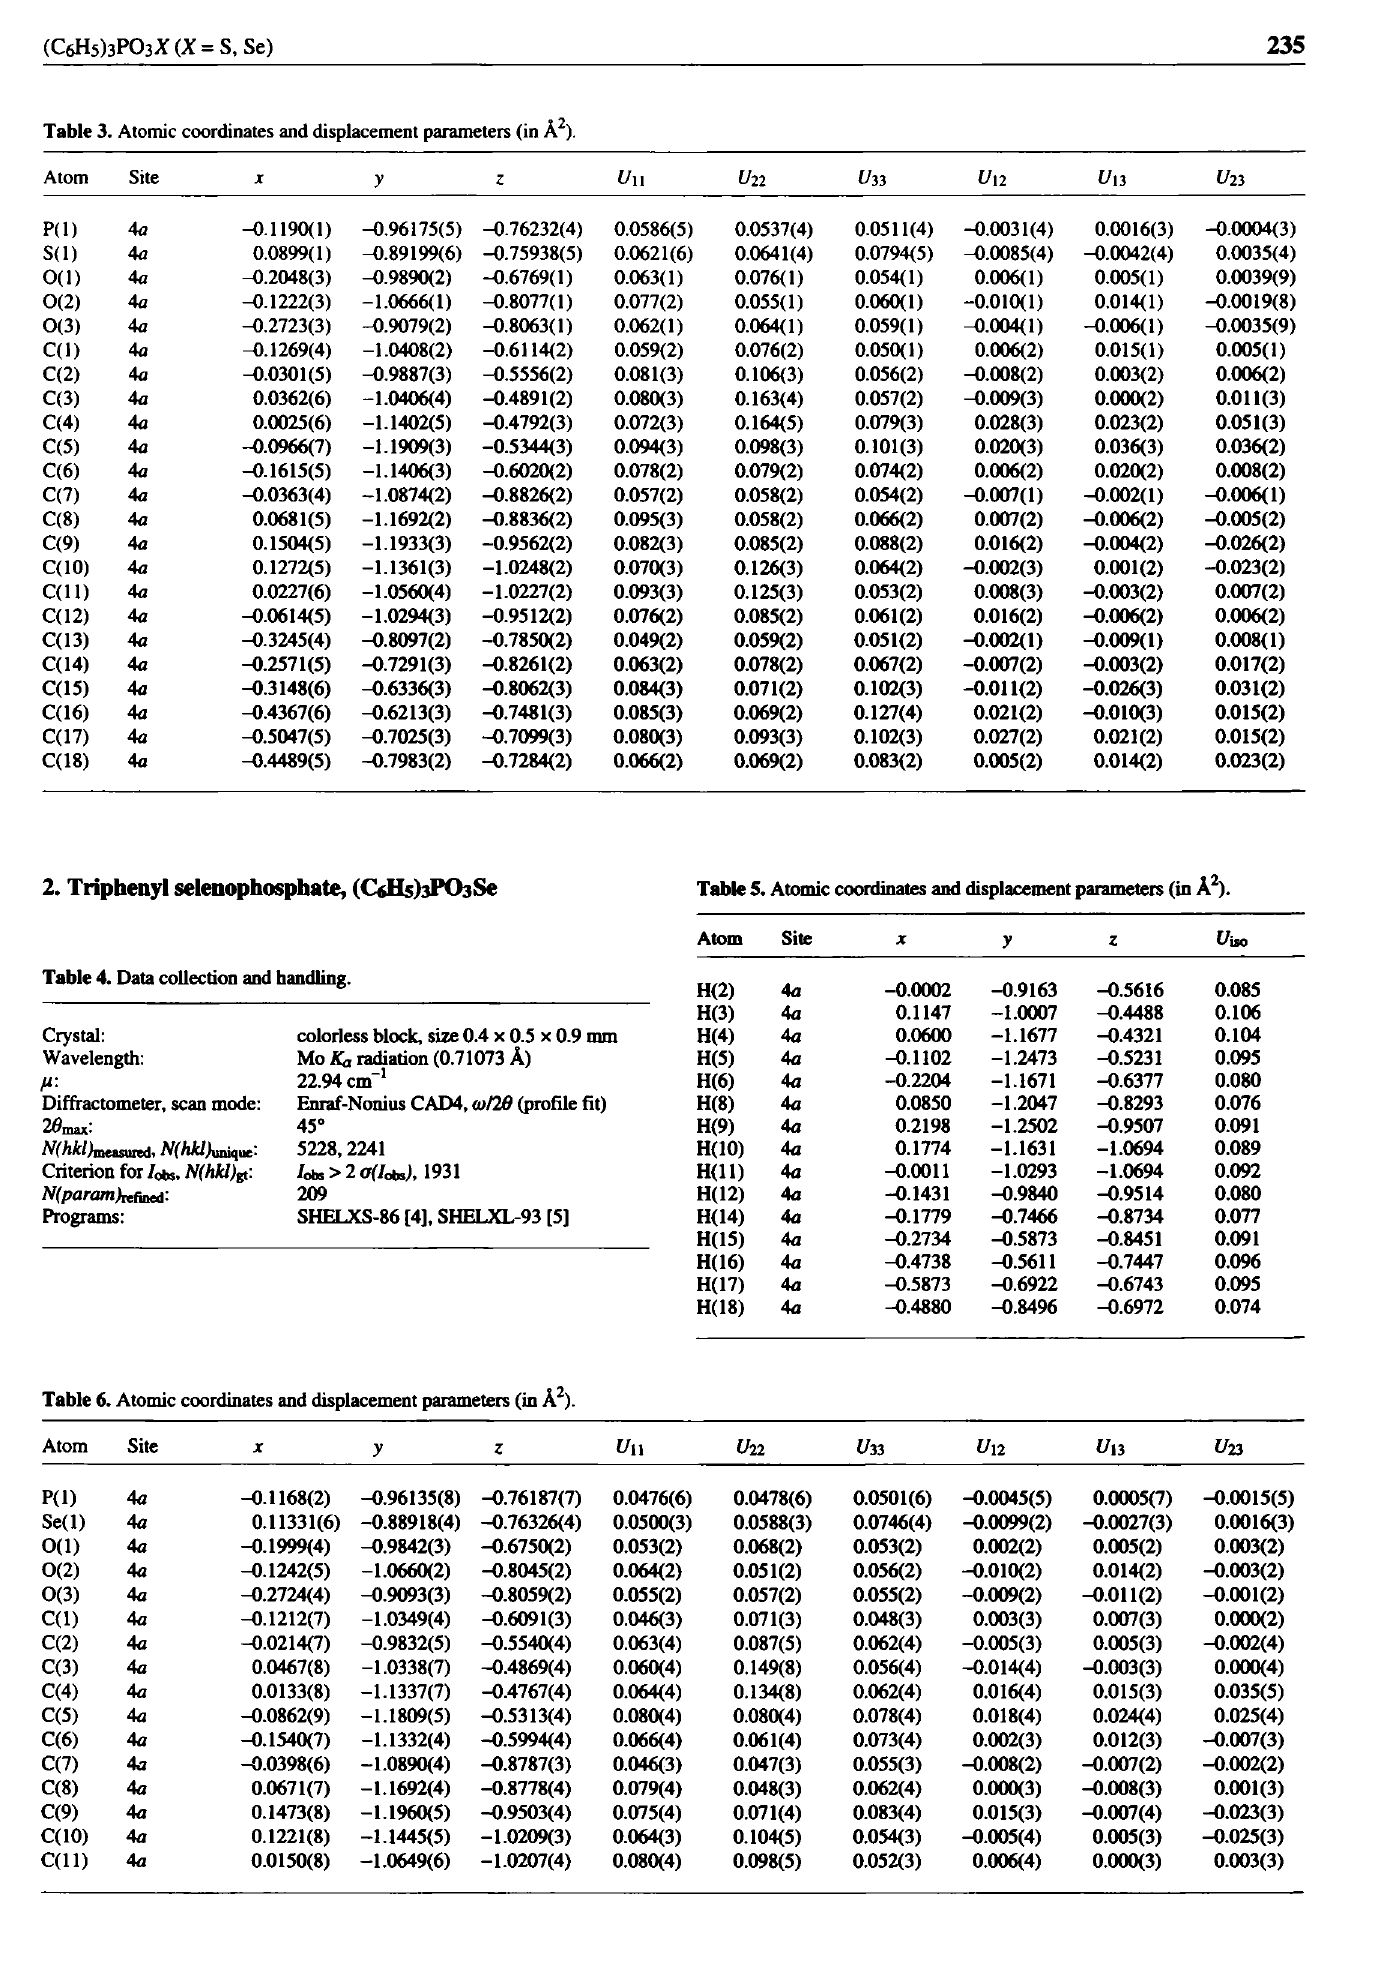
Table 3. Atomic coordinates and displacement parameters (in Ä 2 ).